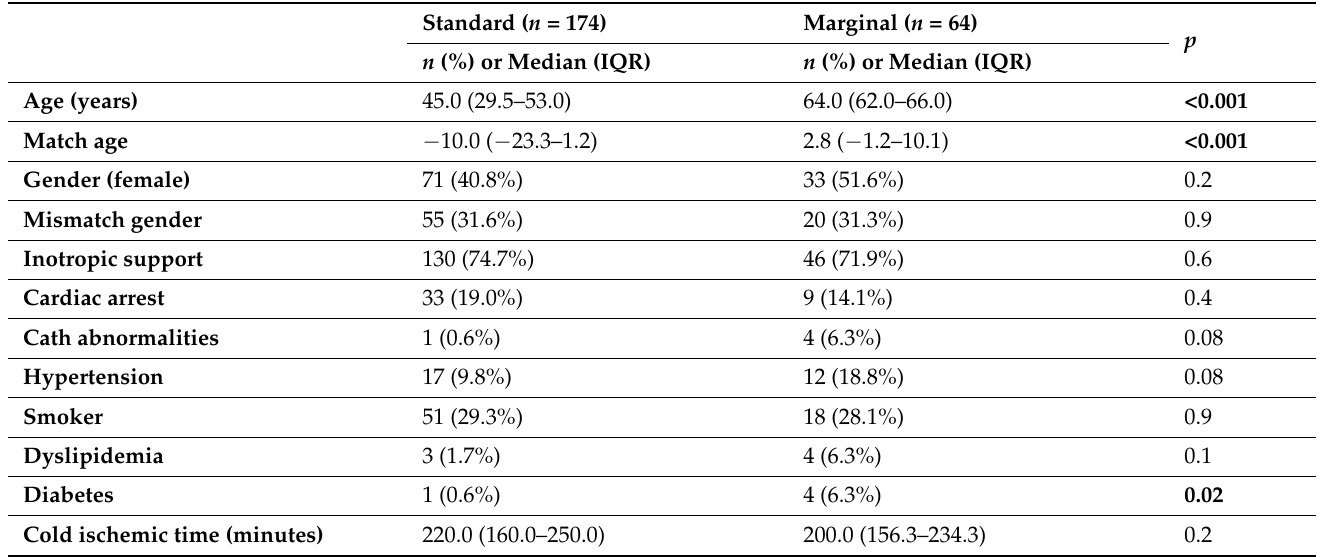
Table 2. Basic characteristics of standard versus marginal